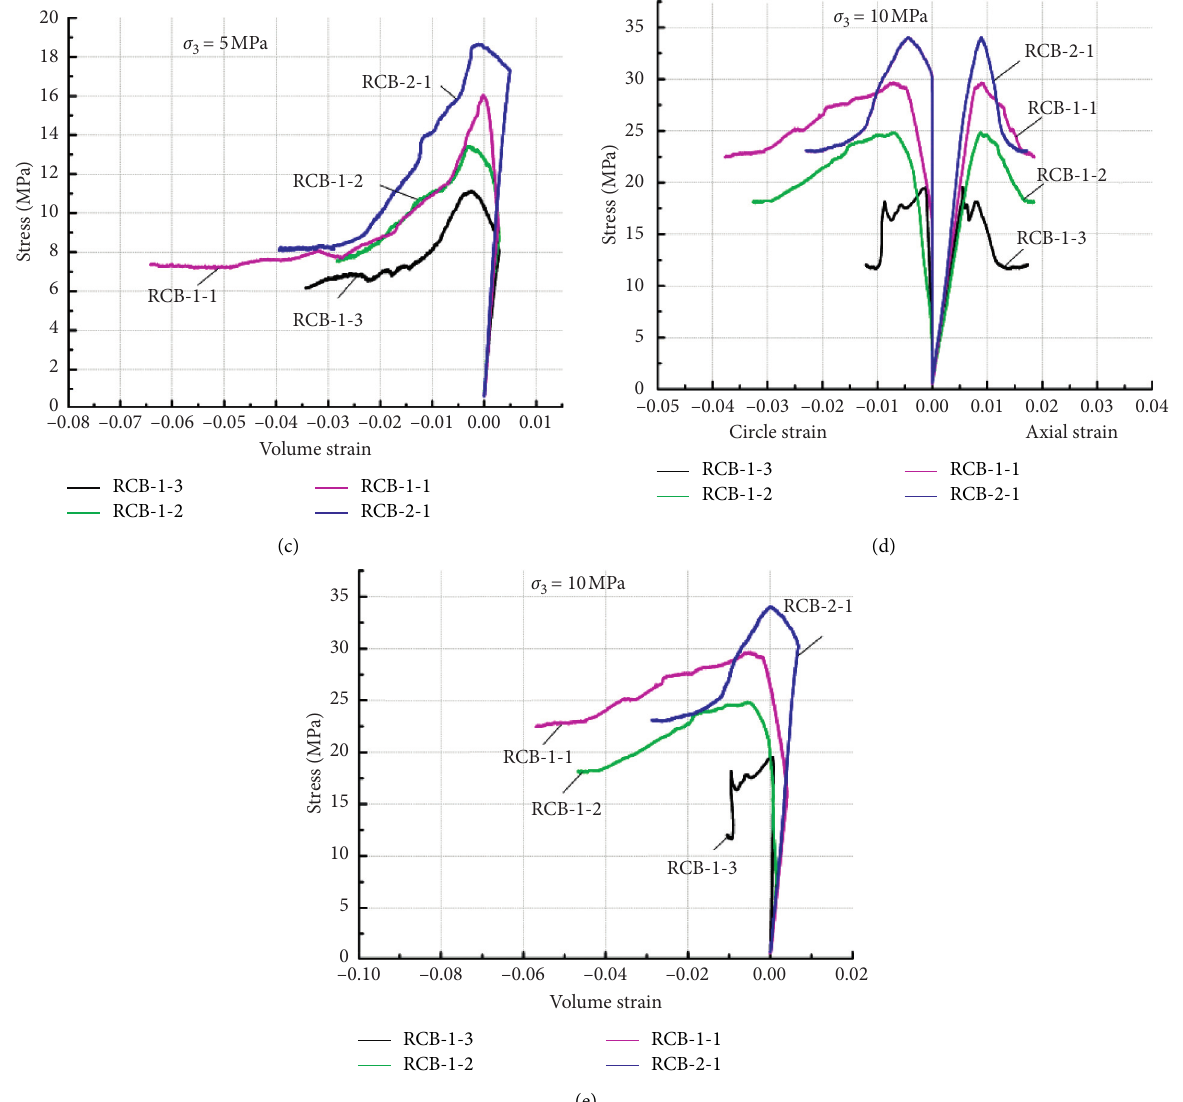
Figure 6: Axial stress-strain curve of coal-rock combination. (a) Axial strain of coal-rock combination under uniaxial loading. (b, c) The axial and circumferential strains and volume strains of coal-rock combined samples when the confining pressure is 5MPa. (d, e) The axial and circumferential strains and volume strains of coal-rock combined samples when the confining pressure is